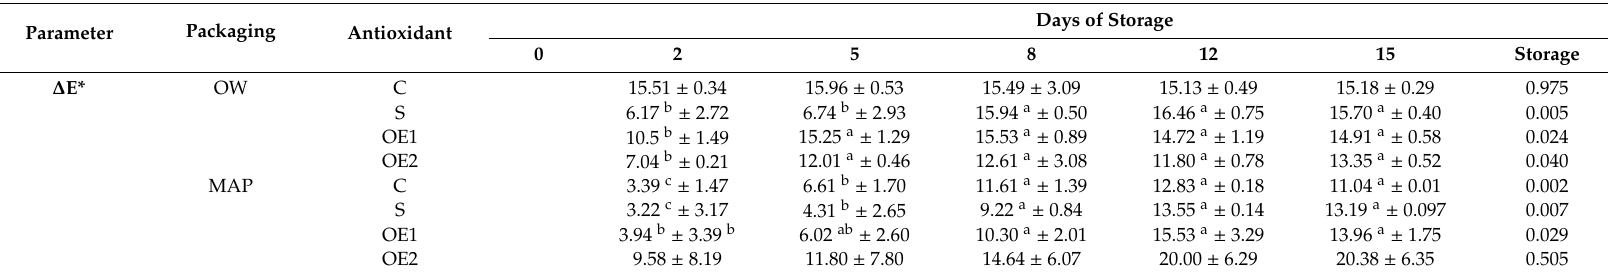
Table 5. The total color di ff erence parameter ( ∆ E*) between patties at Day 0 and the rest of the days α packed under di ff erent conditions β during storage at 4 ◦ C.